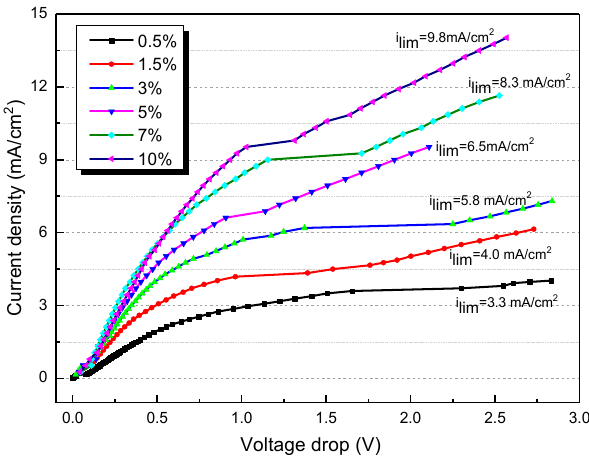
Figure 2. The current–voltage curves for different contents of tobacco extract.